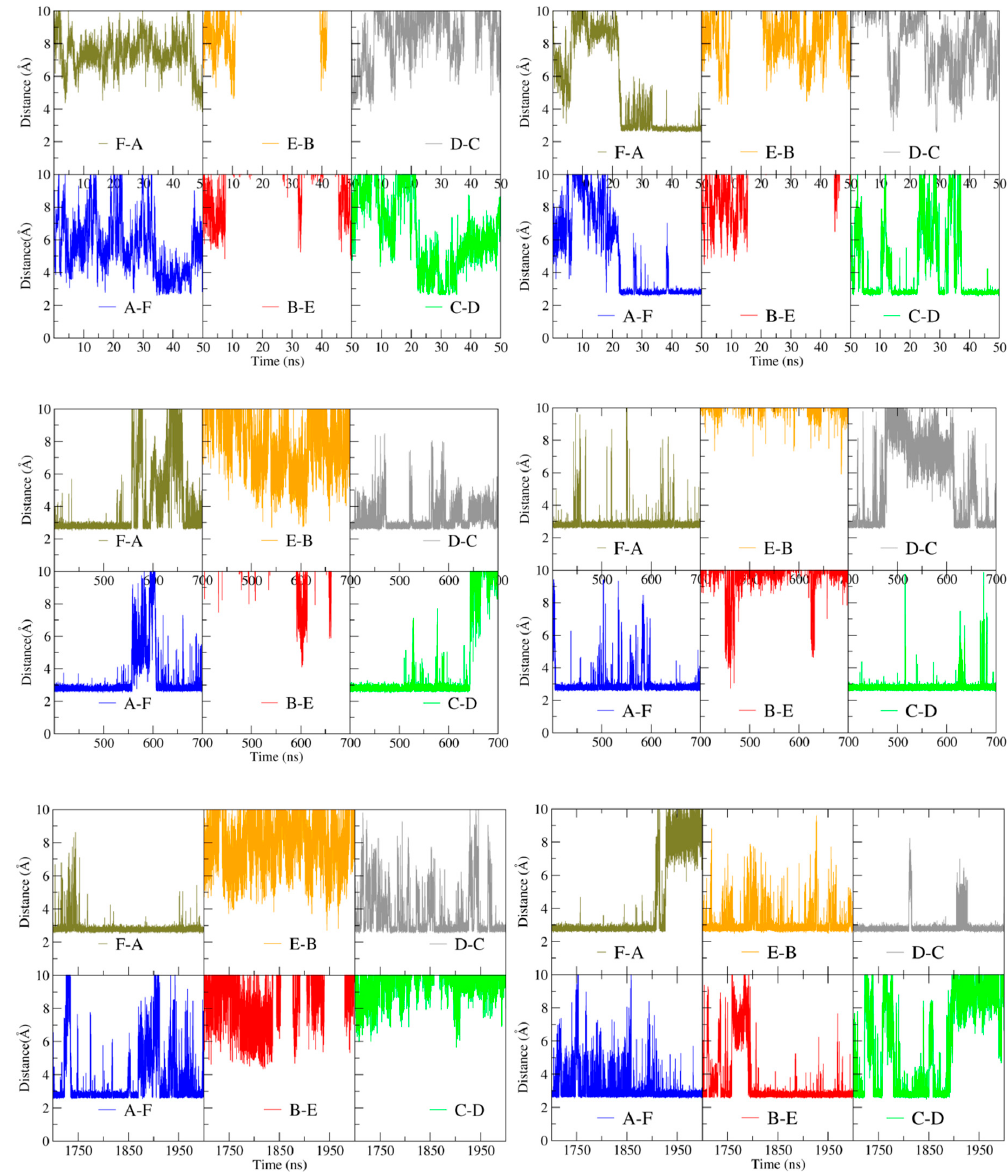
Figure 6. Interactions driving rotation. Left, apoBsArgR; right, holoBsArgR. Colors correspond to subunits in Figure 3. Distance between guanidino nitrogen atoms of Arg78 and carboxylate oxygen atoms of Asp82 is plotted for subunit pairs during three time windows of the rotational time course shown in Figure 4; these distances over the full time course are presented in Figure S2. Letters in lower right of each panel indicate the subunit pairs whose inter-residue distances are measured as identified in Figure 3. The first 50 ns of the simulations is shown in the top panels; 400–700 ns is shown in the middle panels; the final 300 ns is shown in the bottom panels.